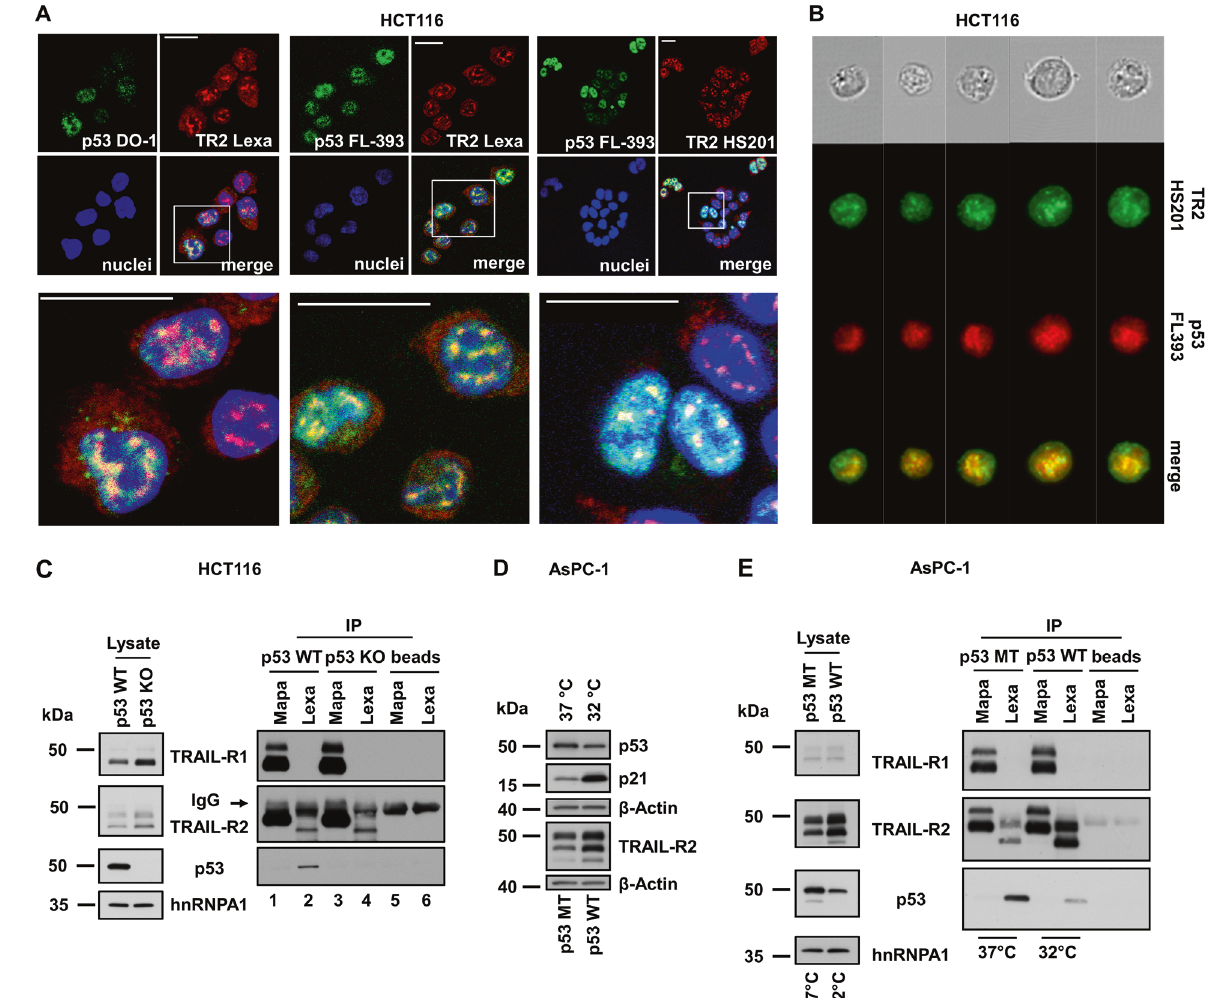
Fig. 1 TRAIL-R2 interacts with p53 in the nucleus. Intracellular distribution of TRAIL-R2 and p53 in HCT116 cells was analyzed by indirect immuno fl uorescence followed by ( A ) confocal LSM and ( B ) ImageStream high-throughput microscopy. Scale bar 20 µm. The respective antibody controls are shown in Supplementary Fig. 1. C TRAIL-R1 and TRAIL-R2 were precipitated from nuclear fractions of HCT116 p53 WT and p53 KO cells by receptor-speci fi c antibodies (Mapa — Mapatumumab, anti-TRAIL-R1 antibody, lane 1 and 3; Lexa — Lexatumumab, anti- TRAIL-R2 antibody, lane 2 and 4). As controls, antibodies alone were analyzed in parallel (lane 5, 6). Nuclear lysates and precipitated protein complexes were examined by western blotting (anti-p53 antibody DO-1). As gel loading control the levels of nuclear protein hnRNPA1 was analyzed in parallel. D AsPC-1 p53 null cells were stable transfected with a temperature-sensitive p53-mutant. These cells express mutant-p53 (p53 MT) at 37 °C and wild-type p53 (p53 WT) at 32 °C. Whole-cell lysates of AsPC-1 cells cultured for 24 h at 37 °C or 32 °C were analyzed for the presence of TRAIL-R2, p53 (anti-p53 antibody DO-1) and p21 by western blotting. The level of β -Actin was determined in parallel and served as loading control. E TRAIL-R1 and TRAIL-R2 were precipitated from nuclear fractions of AsPC-1 cells cultured for 24 h at 37 °C or 32